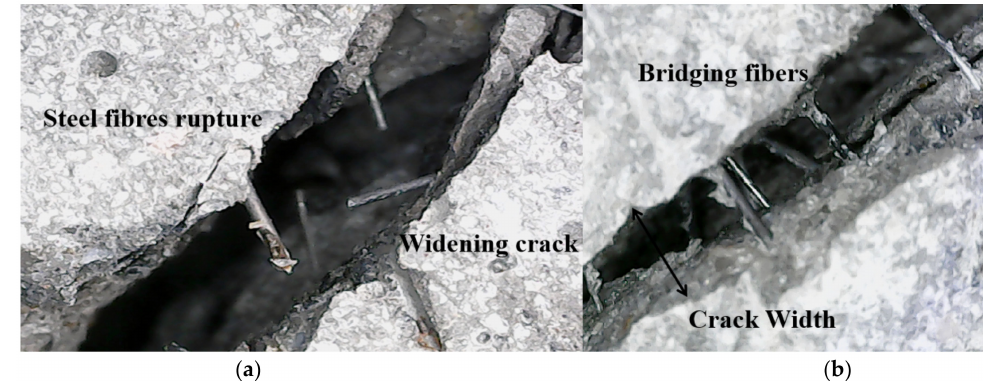
Figure 7. Failure mode and effect of steel fibers. ( a ) Rupture; ( b )